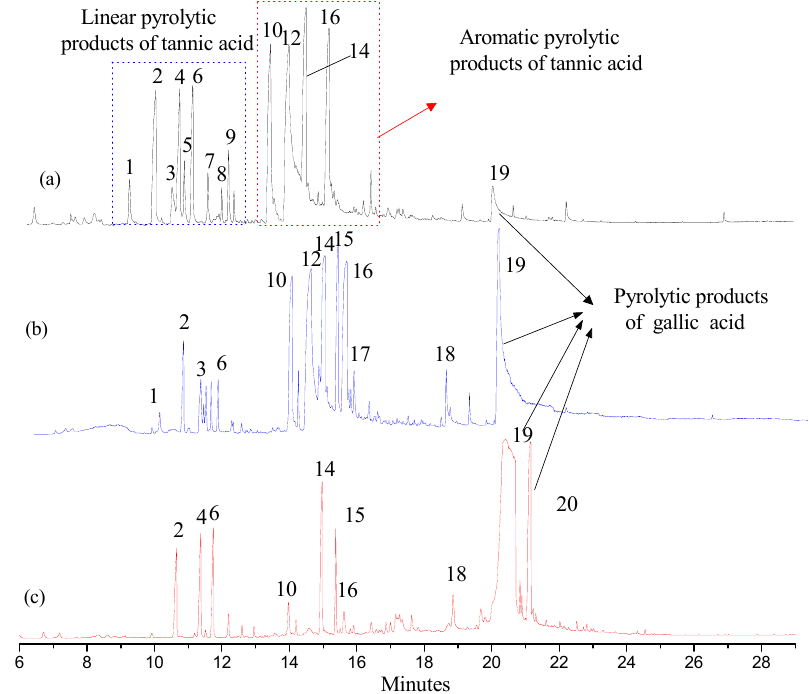
Figure 5. The total ion chromatography of three samples with pyrolysis–gas chromatography–mass spectrometry (Py-GC/MS). ( a ) Tannic acid standard sample (TAS); ( b ) GWE; ( c ) FGWE.